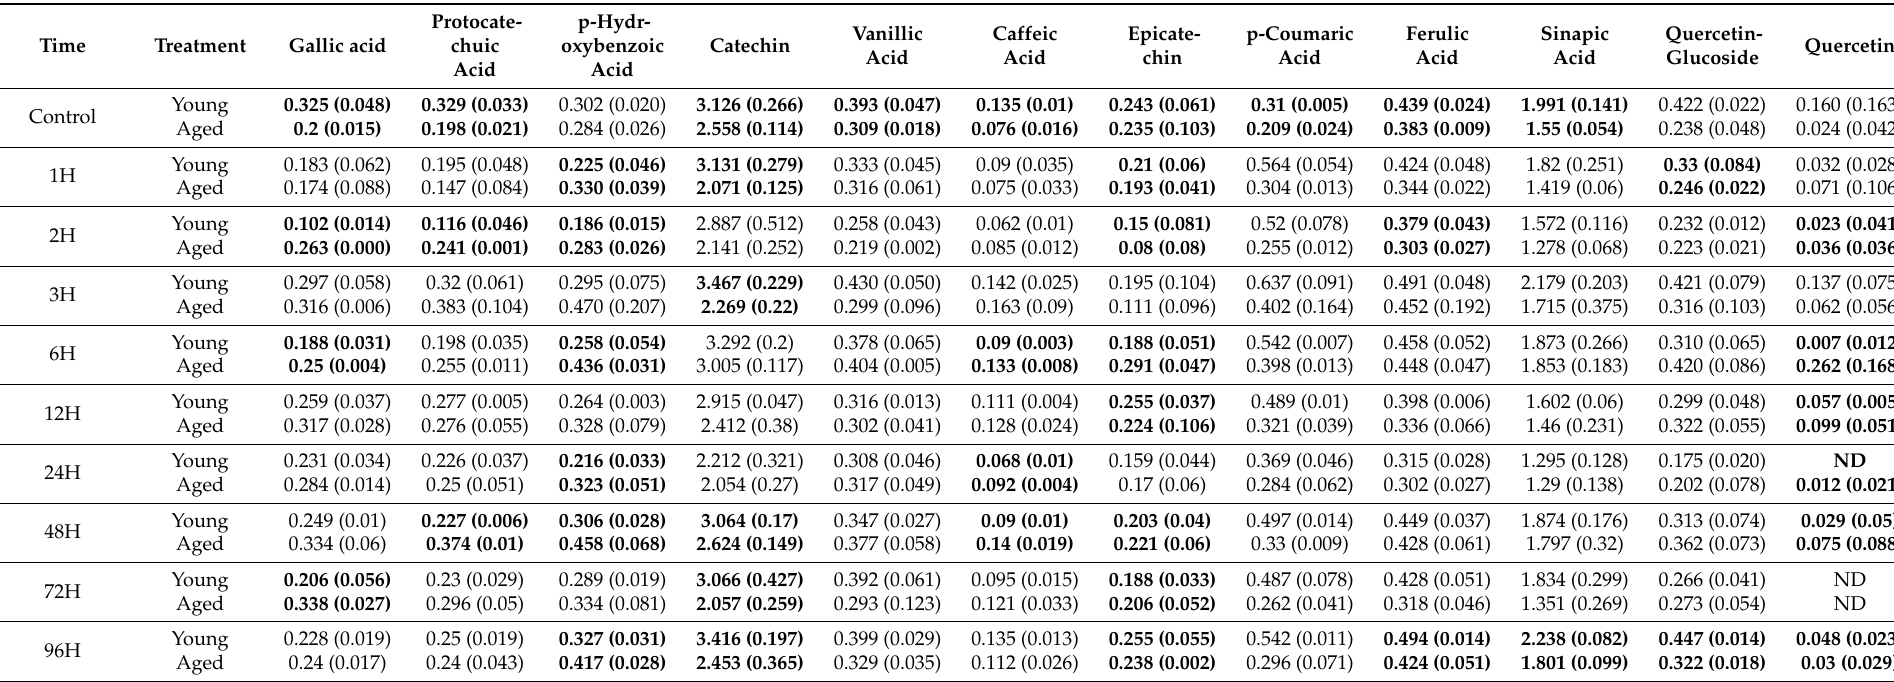
Table A3. Concentrations (mg/L) and standard deviation beer phenolics as determined by LC-MS/MS for young and aged beer. ND = Not Detected. Means for treatment pairs in bold are statistically different at 95% confidence interval by t